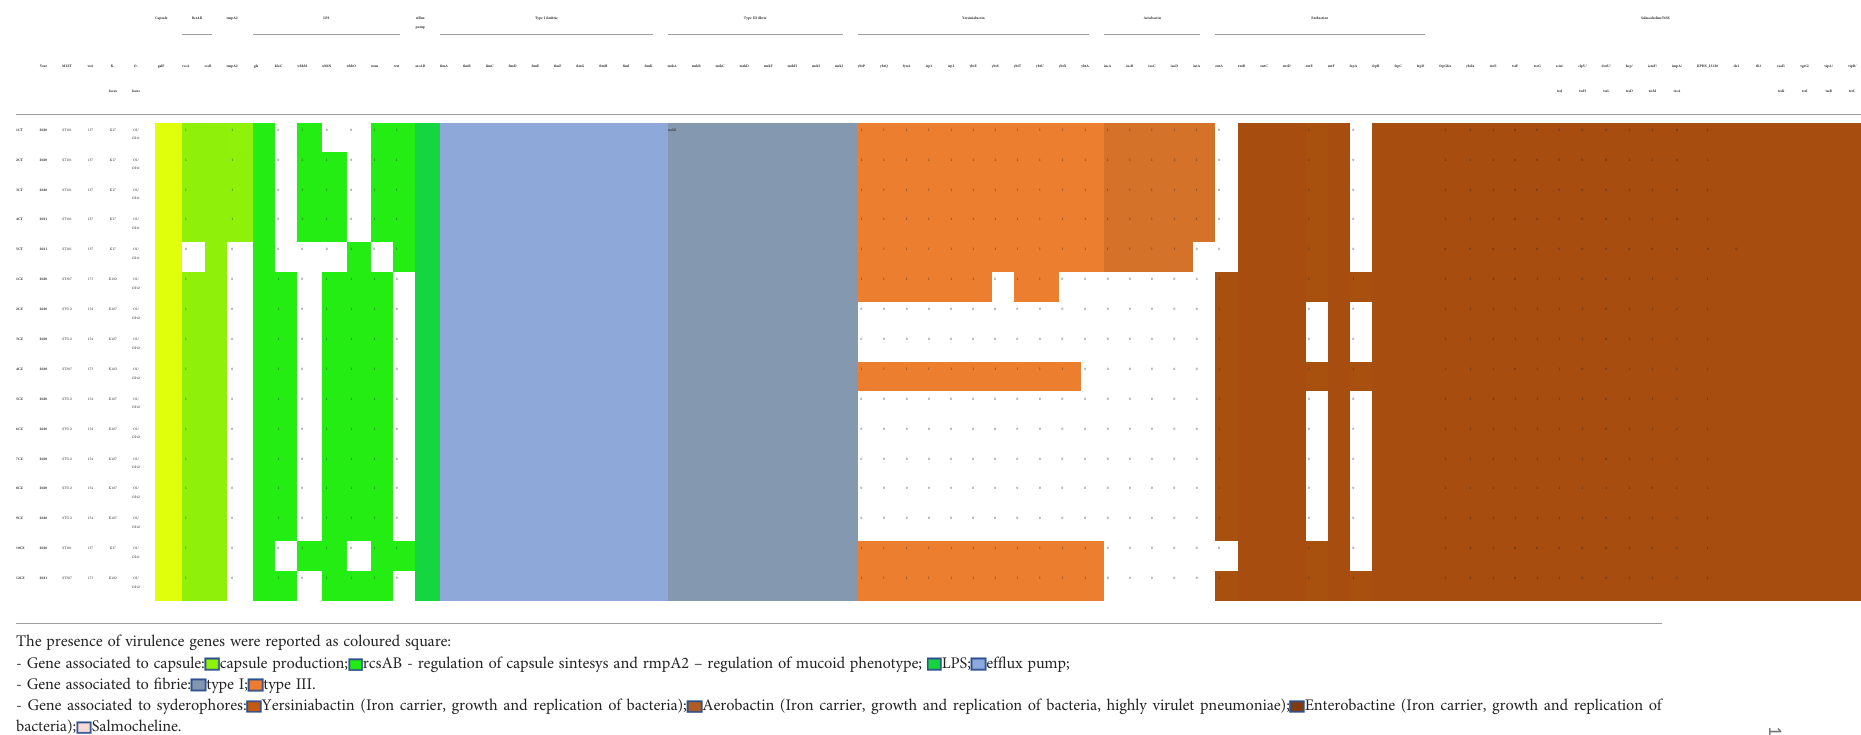
TABLE 4 Virulence Pro fi